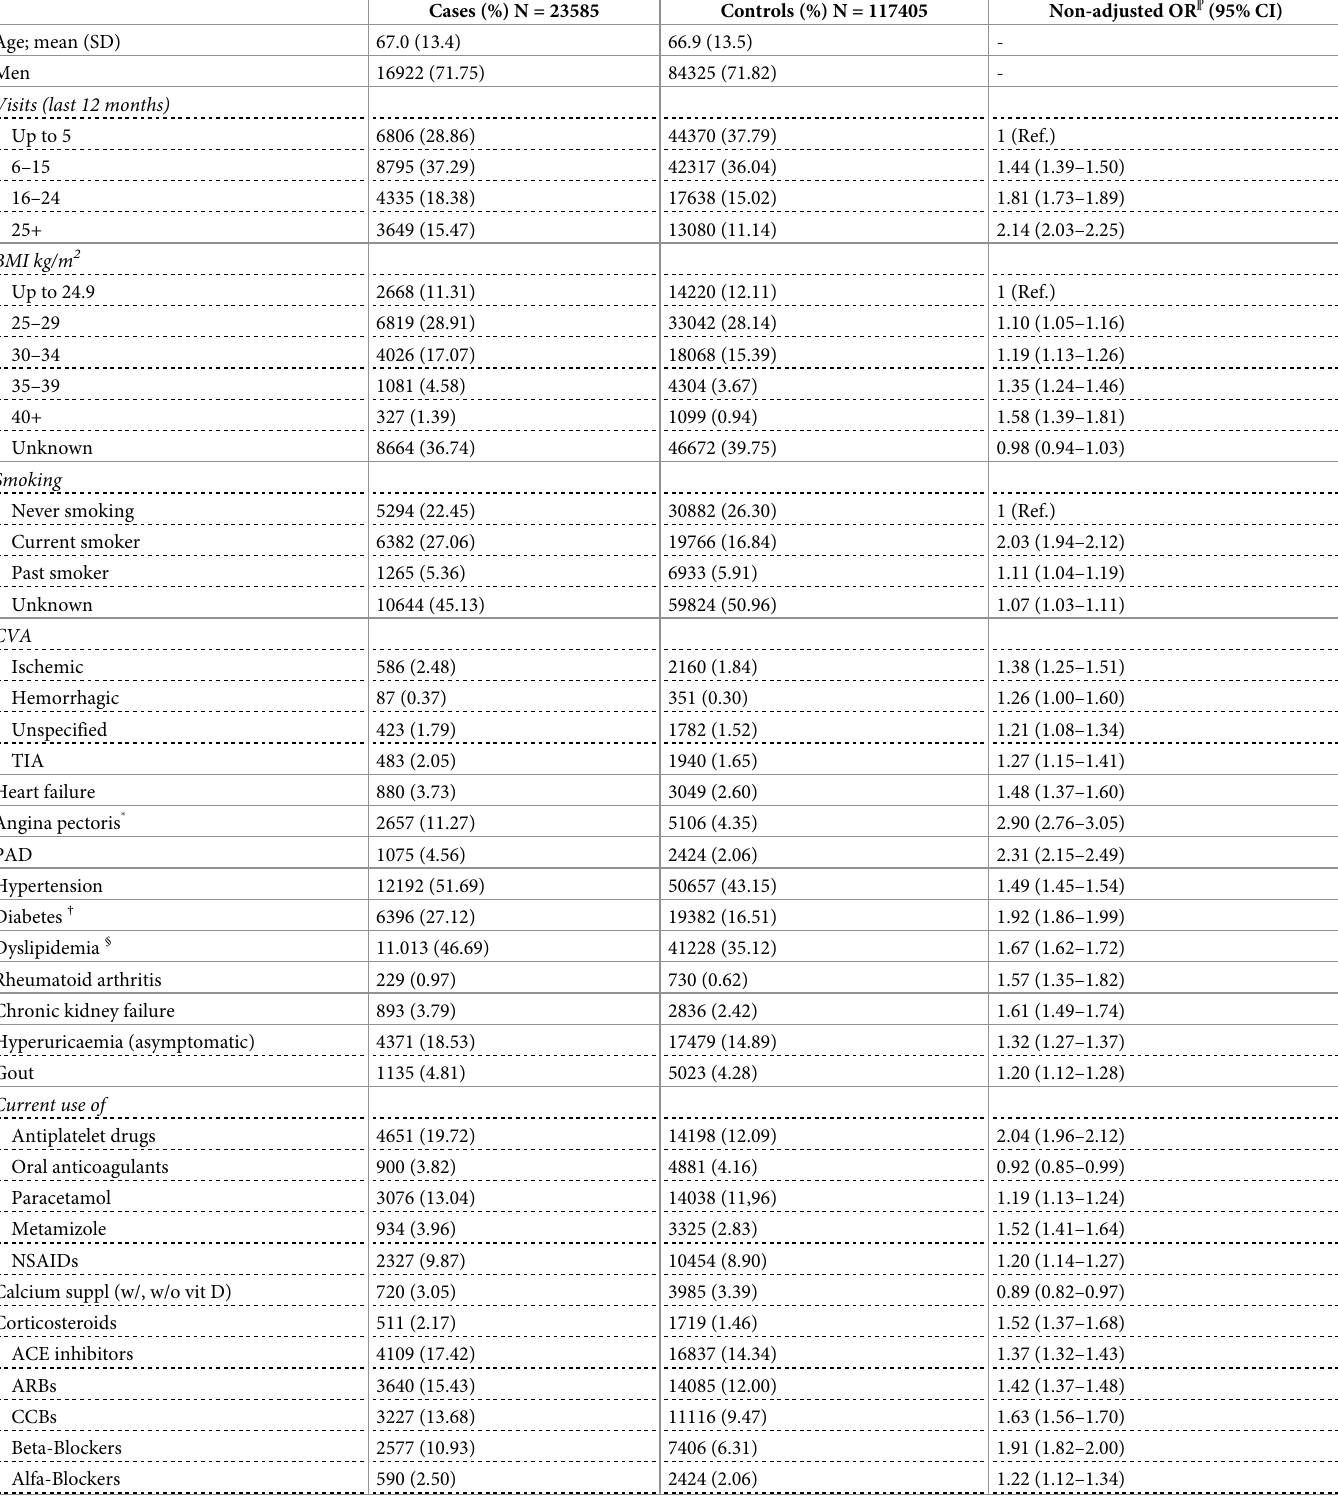
Table 1. Cases and controls characteristics.